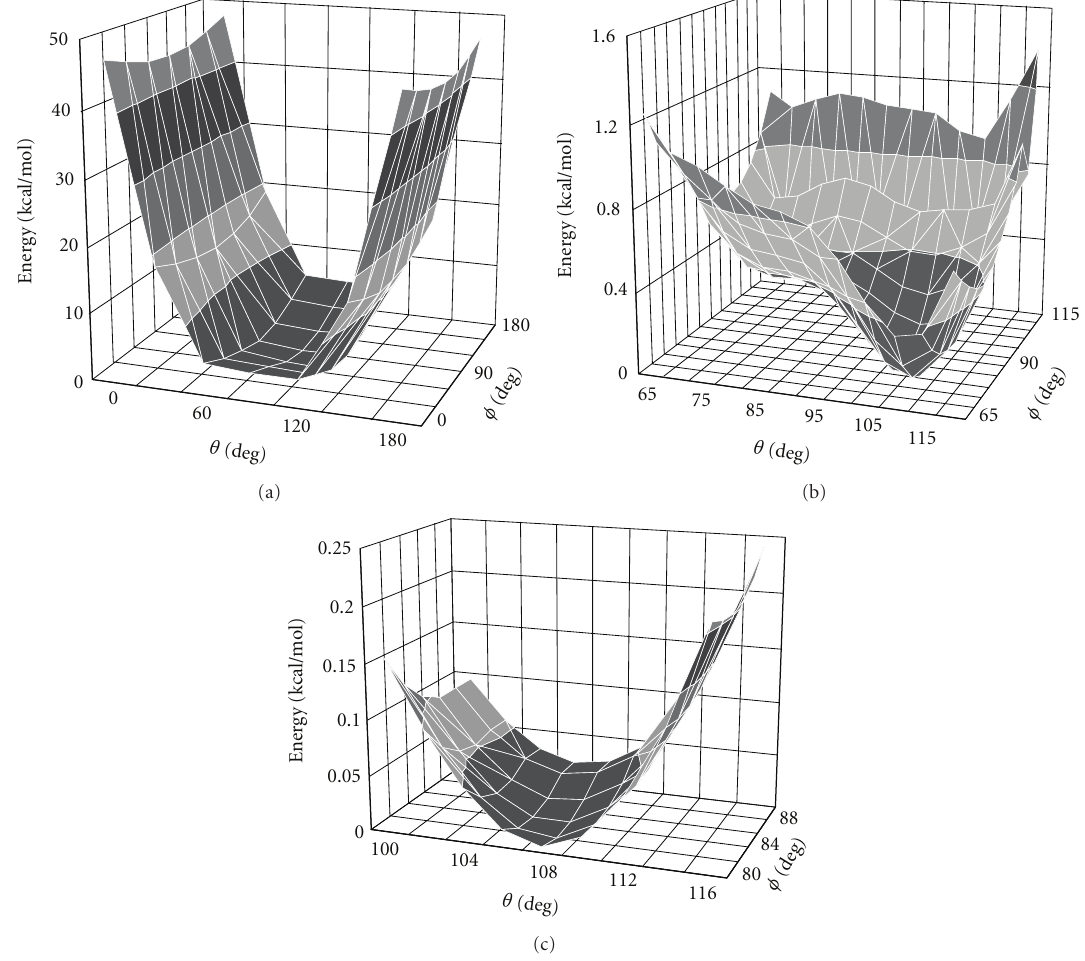
Figure 3: (a)–(c) The potential energy surfaces of the PTP sensitizer compound, where R = R (cid:2) = –H, as a function of the torsion angles ( θ and φ defined in Figure 2), optimized manually at the angle intervals 30 ◦ , 5 ◦ , and 2 ◦ , respectively.